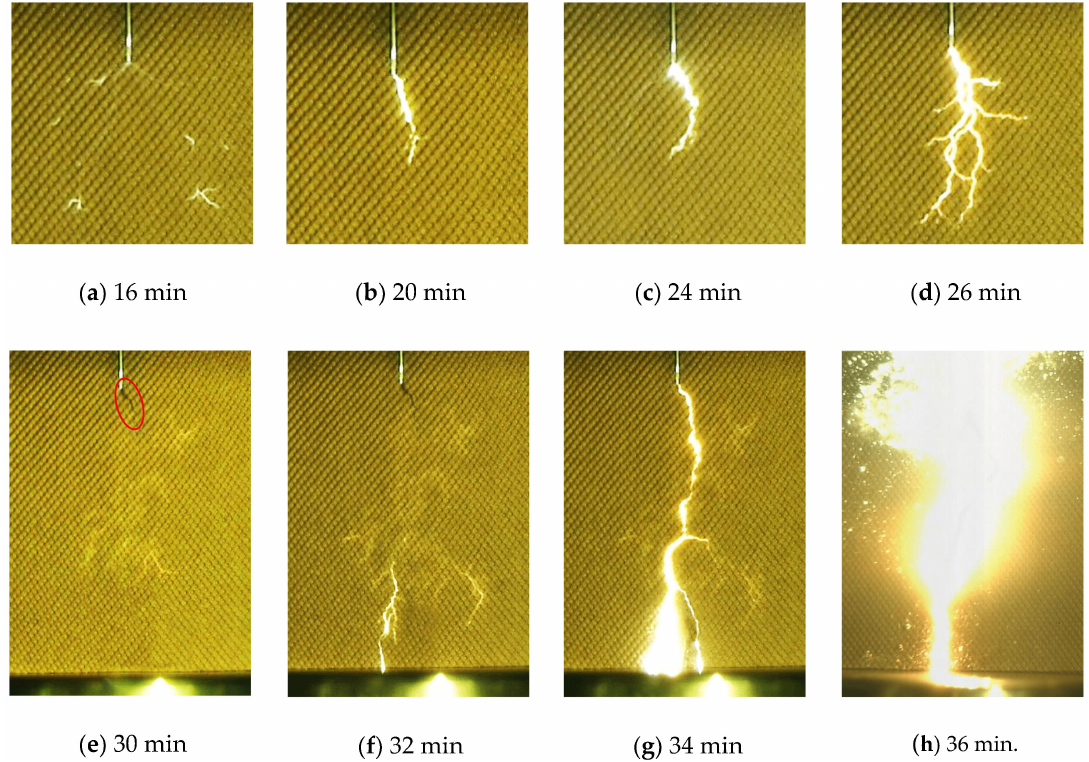
Figure 6. The development process of surface tracking under 4 µ m